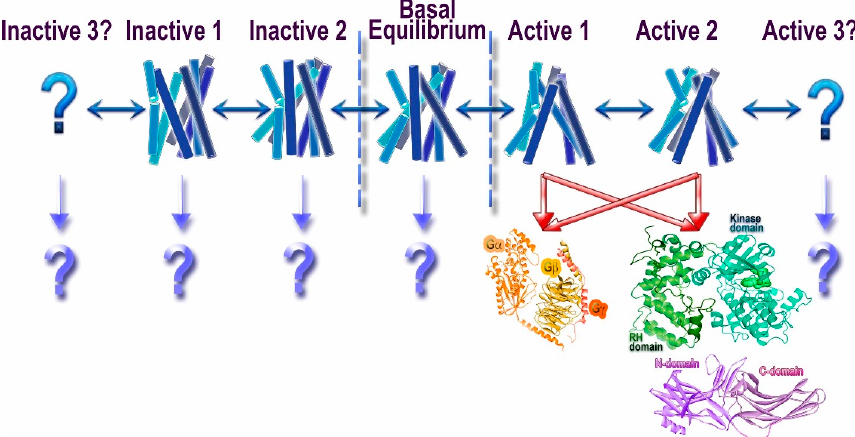
Figure 1. Conformational heterogeneity of G protein-coupled receptors (GPCRs) and signaling. Unliganded GPCRs appear to exist in the equilibrium between multiple conformations (basal equilibrium), which the agonists partially shift towards active conformations [10]. It is likely that there are several “active” conformations of GPCRs (shown as Active 1, 2, and 3). The most realistic scenario is that the great majority of active conformations effectively couple to G proteins, GRKs, and arrestins. However, there likely are some that might preferentially engage distinct signal transducers, such as different G proteins, GRKs, and/or arrestins (this phenomenon is called biased signaling). While the idea that the receptor conformations preferred by G proteins and GRKs/arrestins do not fully overlap appears attractive, we do not have direct structural evidence to support it. Similarly, another idea that phosphates in different positions on the cytoplasmic GPCR elements encode distinct conformations of bound arrestins and therefore functional outcomes [11,12] is enticing, but it also awaits supporting structural evidence. The binding of presumably inactivating inverse agonists also does not shift the equilibrium to a single conformation, suggesting that there might be multiple different inactive states (shown as Inactive 1, 2, and 3). Whether any of these conformations facilitate the engagement of distinct interaction partners remains to be elucidated (shown as “?”).